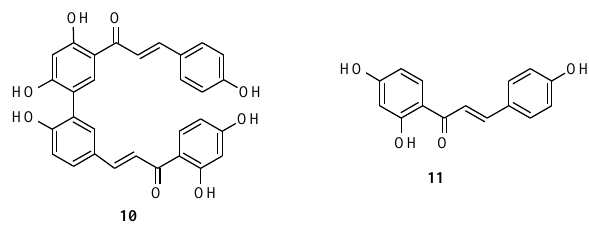
Figure 2. Structures of a rhuschalcone and its